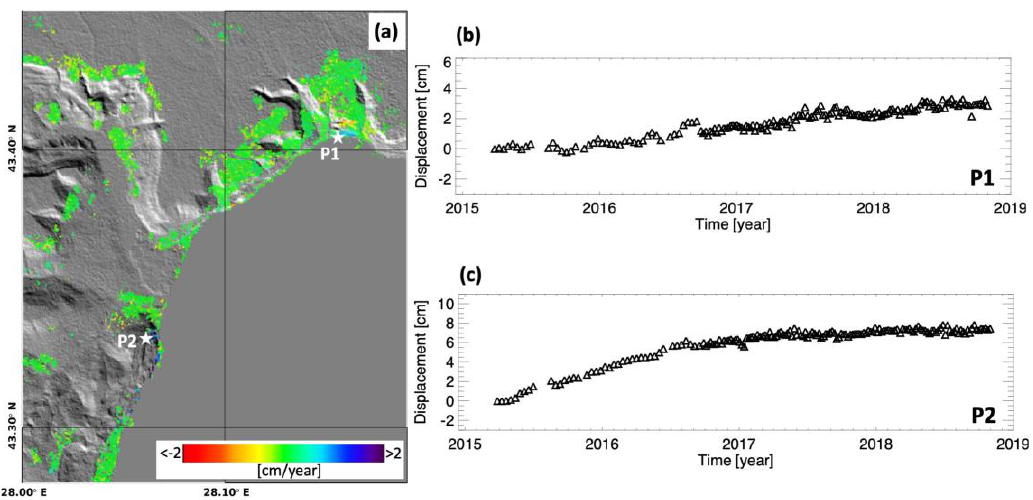
Figure 15. Zoomed-in view of the mean deformation velocity map relevant to the Northern Black Sea coast (Bulgaria). ( a ) LOS mean deformation velocity map superimposed on the SRTM DEM of the zone. ( b , c ) Displacement time series relevant to the pixels, marked by the white stars in ( a ) and located in the areas of Balchik town (P1) and Kranevo village (P2), both affected by landslides movements.